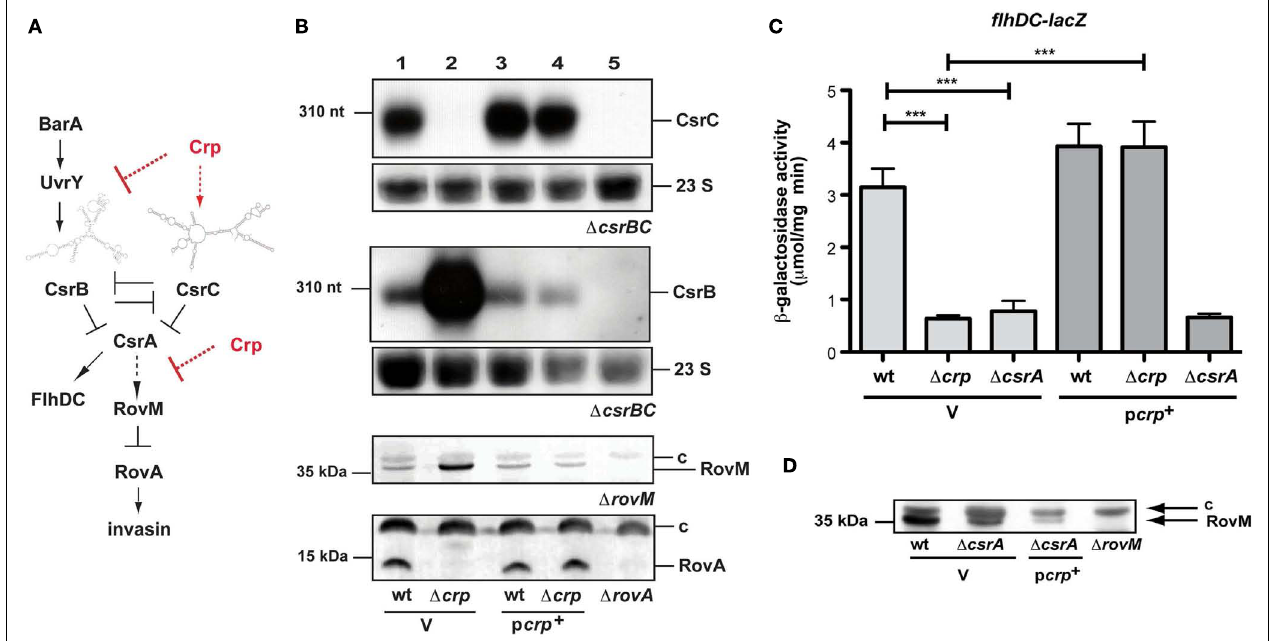
RNA loading control, the sizes of RNA or protein markers are given on the left.The respective negative controls are loaded in the last lanes:YP79 ( ∆ csrBC , two upper panels),YP3 ( ∆ rovA ) thrid panel,YP72 ( ∆ rovM ) lowest panel. (C) To investigate Crp-dependent flhDC expression in the absence of csrA , the empty vector pAKH85 (V) or its crp + derivative pAKH37 (p crp + ) were transformed into Y. pseudotuberculosis strainsYPIII, YP89 ( ∆ crp ) orYP53 ( ∆ csrA ) harboring a flhDC´-´lacZ fusion (pAKH58).The bacteria were grown overnight in LB medium at 25˚C. β -Galactosidase activity from overnight cultures was determined and is given in µ molmin − 1 mg − 1 for comparison.The data represent the average ± SD from at least three different experiments each done in duplicate. (D) Analysis of Crp-dependent RovM protein levels in the absence of csrA . Whole cell extracts from overnight cultures of the Y. pseudotuberculosis wildtype strainYPIII andYP53 ( ∆ csrA ) harboring the empty vector pAKH85 (V) or the crp -encoding plasmid pAKH37 (p crp + ) grown at 25˚C were prepared, and analyzed by western blotting with polyclonal antibodies directed against RovM.The negative controlYP72 ( ∆ rovM ) is loaded in the last lane.The loading controls for the western blots are marked with